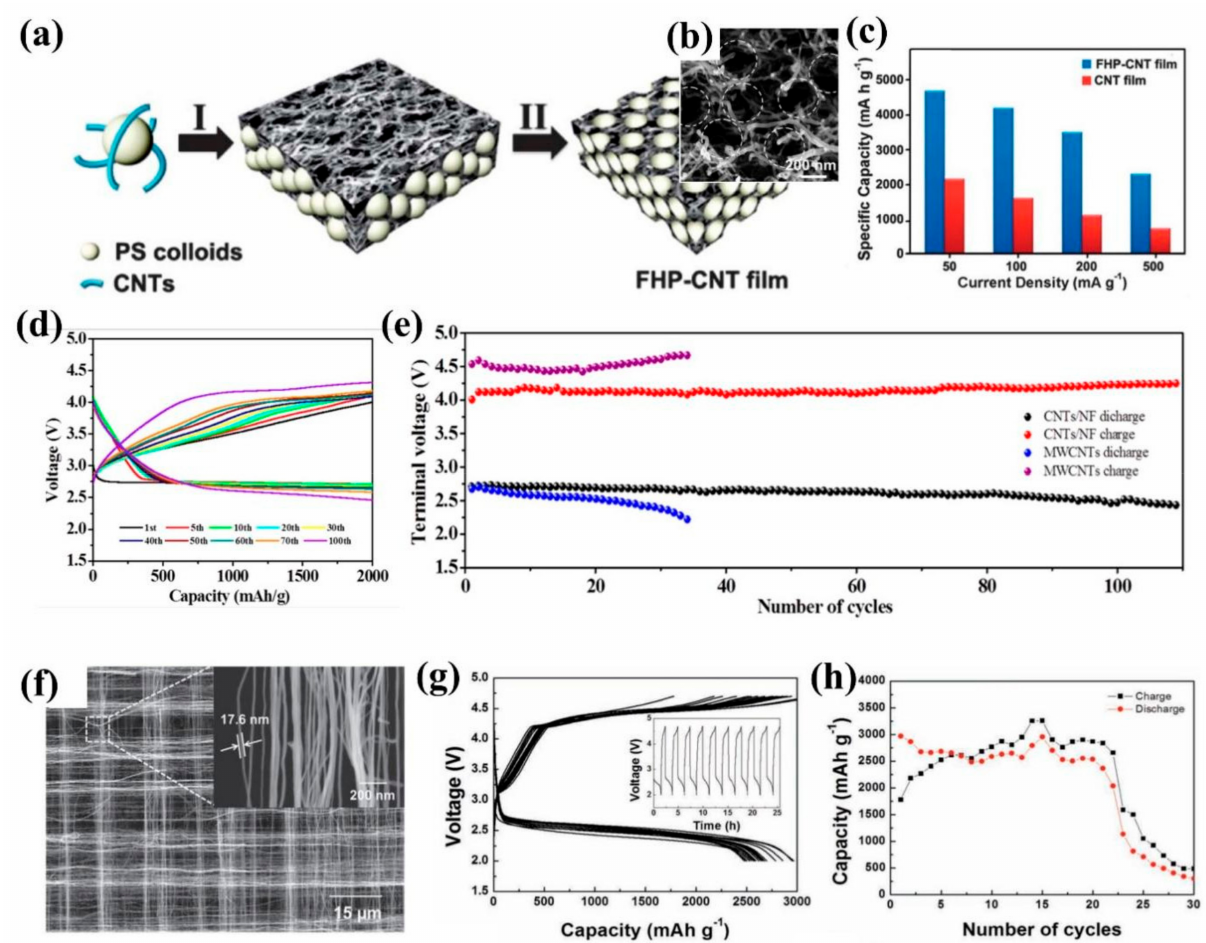
Figure 3. ( a ) Schematic diagram of multi-layer porous carbon nanotube film preparation process. ( b ) SEM images of interconnected large tunnels in CNT films. ( c ) Rate performance of pure carbon nanotube films and graded porous carbon nanotube films at different current densities Reprinted with permission from ref. [47]. Copyright 2013 Royal Society of Chemistry. ( d )